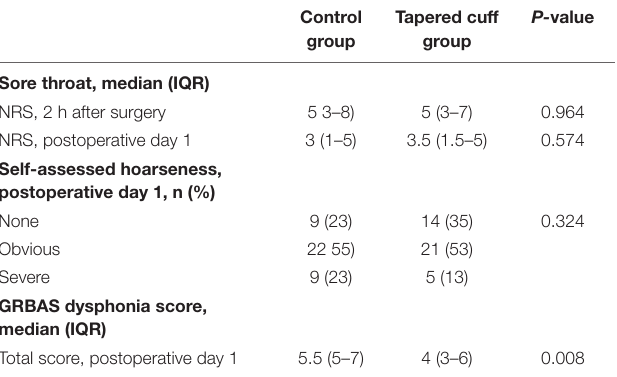
TABLE 4 | Postoperative sore throat and